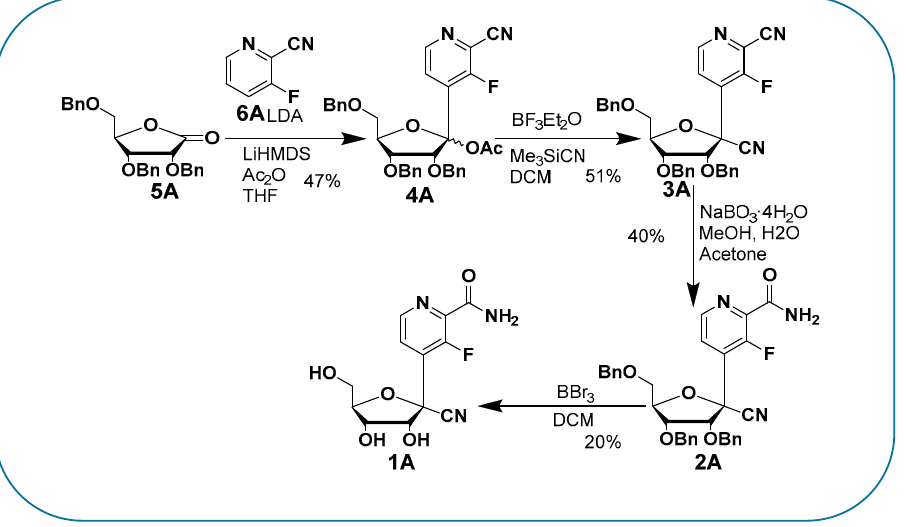
Figure 3. Synthesis of the analogue.